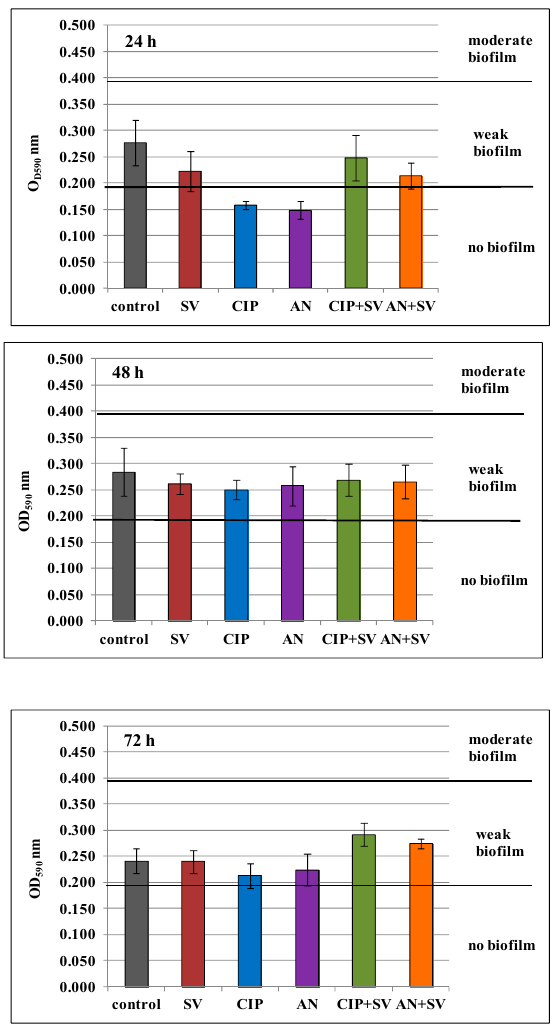
Figure 3. Biofilm formation in the presence of S. virgaurea extract (SV), ciprofloxacin (CIP), amikacin (AN), S. virgaurea extract with ciprofloxacin (CIP+SV) and S. virgaurea extract with amikacin (AN+SV). Values represent the mean ± SD of three separate experiments.